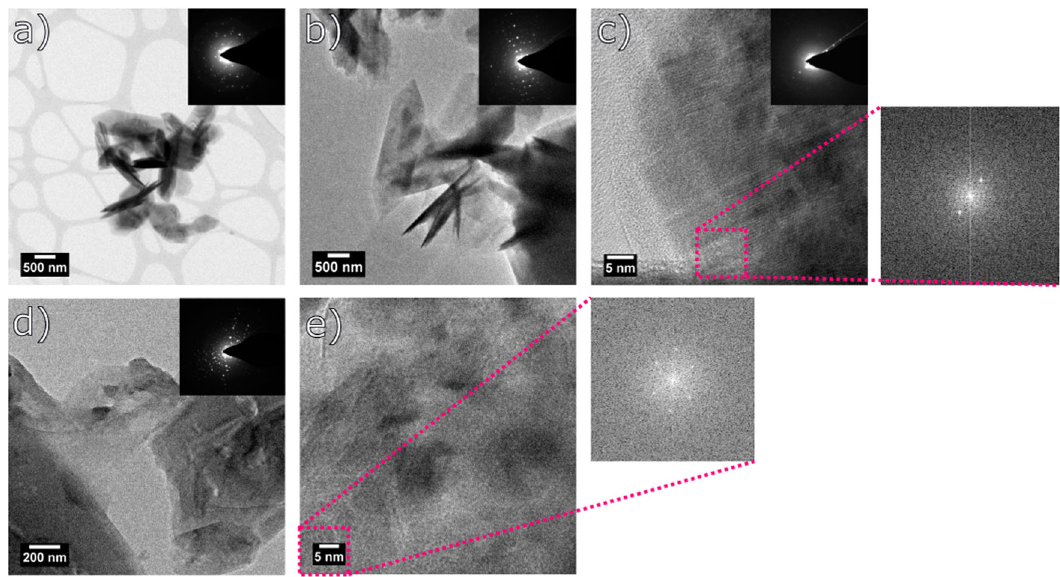
Fig. 9 TEM micrographs and electron diffractograms of the washed samples. TEM images of samples at different a no washing ZIF-L sample, b 6 h washing, c 24 h washing, d 48 h washing and e 72 h washing times with their corresponding SAED and/or Fourier transform measurements.